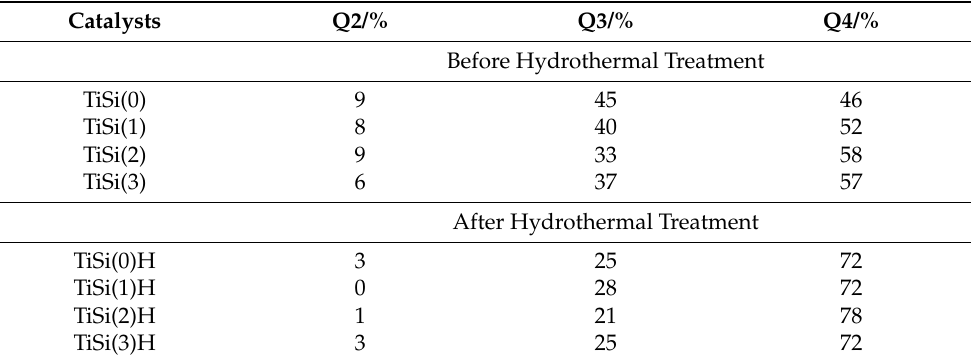
Figure 4. 29 Si NMR images of samples before and after hydrothermal treatment of mesoporous silica with different titanium contents. Table 4. 29 Si NMR characterization results of samples before and after hydrothermal treatment of mesoporous silica with different titanium contents.